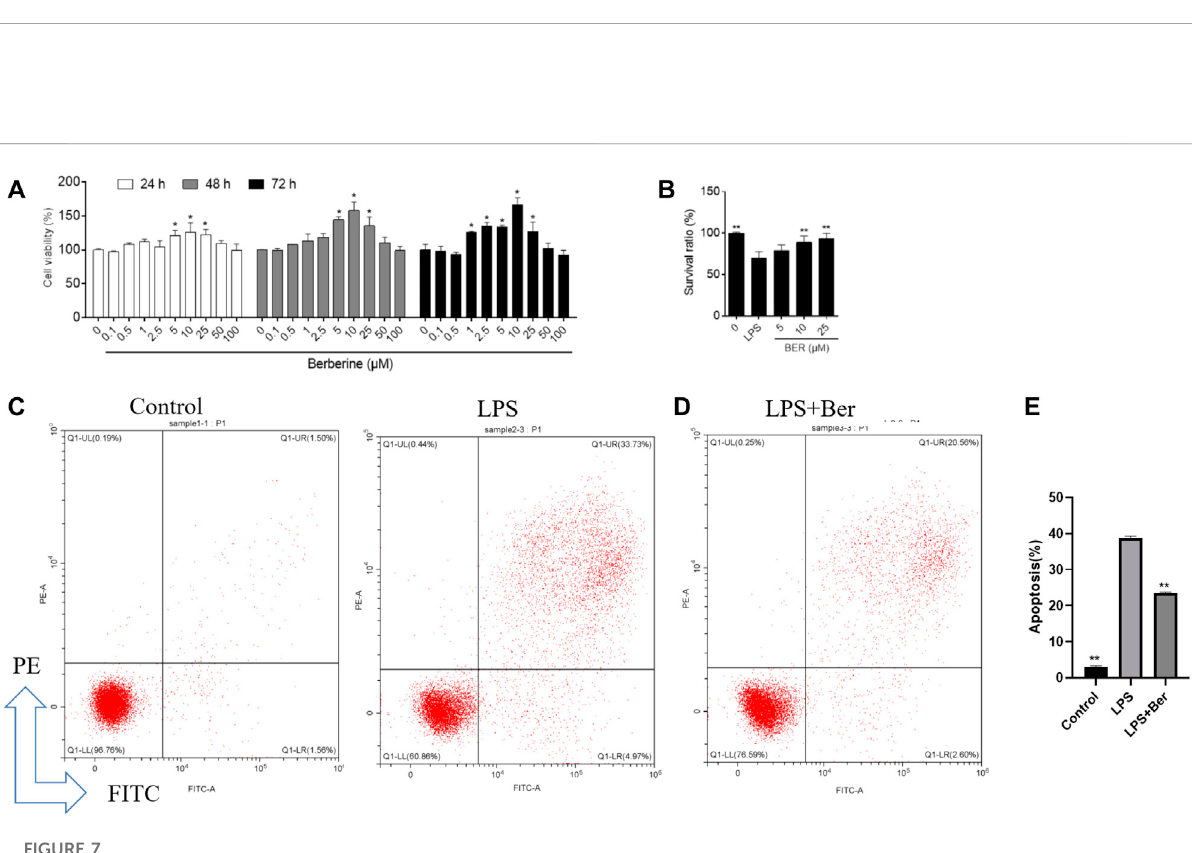
FIGURE 6 (A) Berberine inhibits LPS-induced IL-6, IL-1 β , and TNF- α production in HGFs. The data presented are the means ± SD of three independent experiments. # p < 0.05 versus the control group; * p < 0.05, ** p < 0.01 versus the LPS group. (B) Effects of berberine on BAX, PARP, Caspase-9, Caspase-3, and cytochrome C expression. The values presented are the means ± SD of three independent experiments. ** p < 0.01, LPS versus NC group, LPS versus LPS + Ber group. (C) Effects of berberine on BAX, PARP, Caspase-9, Caspase-3, and cytochrome C expression. The values presented are the means ± SD of three independent experiments. ** p < 0.01, LPS versus NC group, LPS versus LPS + Ber group.